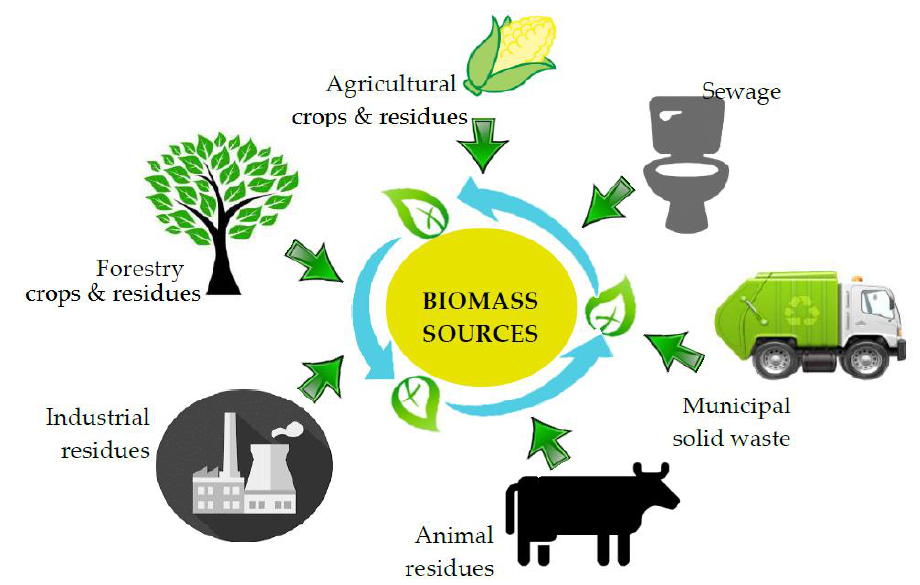
Figure 2. Different types of biomass feedstocks.